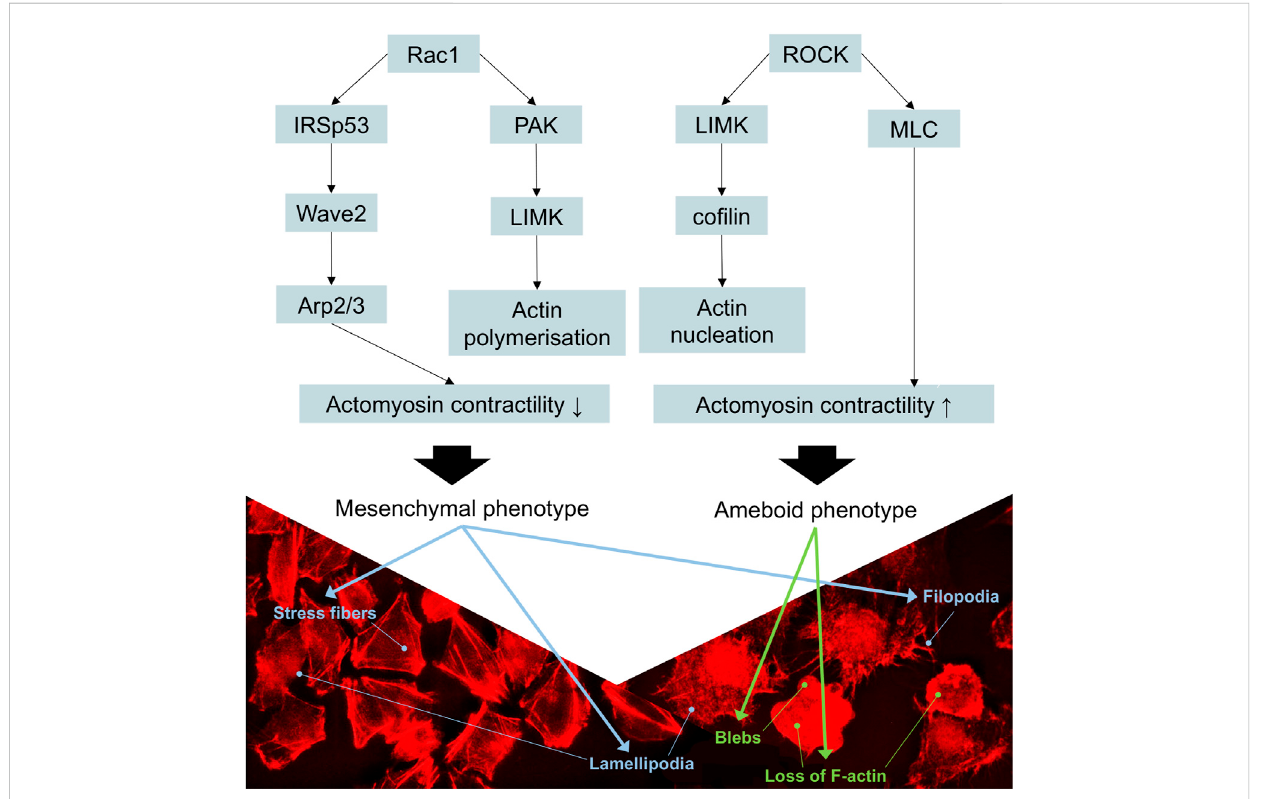
FIGURE 8 Schematic representation of the signaling cascades involved in the movement of melanoma cells. Rac1 activation decreases the contractility of actomyosin, promoting mesenchymal movement, whereas the activation of RhoA/ROCK cascade increases actomyosin contractility, resulting in amoeboid movement. p21-activated kinase (PAK) binds to the GTP-bound form of Rac1, activating the LIM-motif-containing protein kinase (LIMK) to driveco fi lin-mediatedactinturnover.IRSp53(insulinreceptortyrosinekinasesubstratep53)isanadaptorproteinthatbindstoRac1andWave2,thus contributing to the formation of lamellipodia. Stress fi bers, lamellipodia, and fi lopodia are characteristic of mesenchymal phenotype. Rounded morphology, loss of actin fi laments, and formation of blebs are characteristics of ameboid phenotype. Adapted from (Bonaventure et al.,